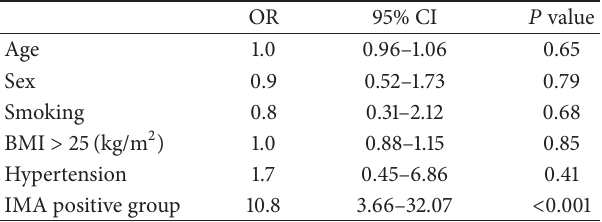
Table 3: Alterations in serum IMA and CRP concentrations and demographic information after 3 months of CPAP